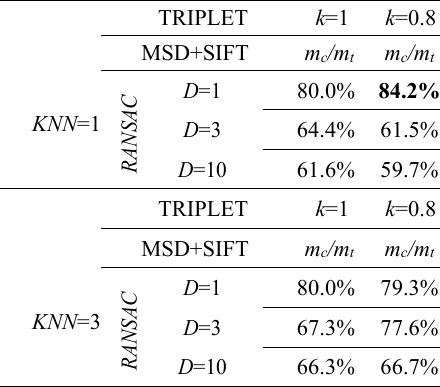
Table 3. Different parameters analysed for the triplet detector/descriptor/matcher (MSD+SIFT+RM) in the multi- modal dataset. m c and m t refer to correct matchings and total matching, respectively. In bold the combination which provides the best